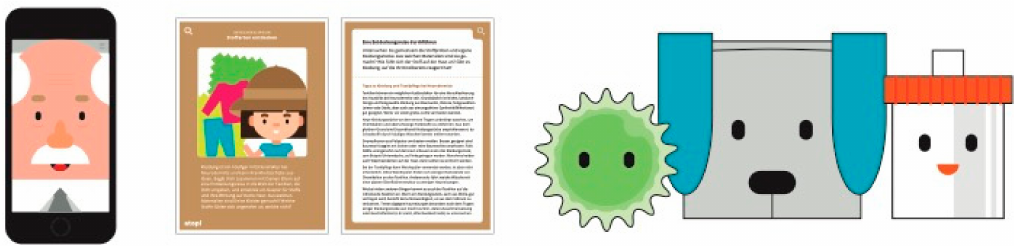
Figure 2. Elements of the atopi Box that especially stress the positive approach, from left to right: Dr. Atopi app, fabric expedition card (front and back), and toy-like characters “Sparkle”, “Coolie”, and